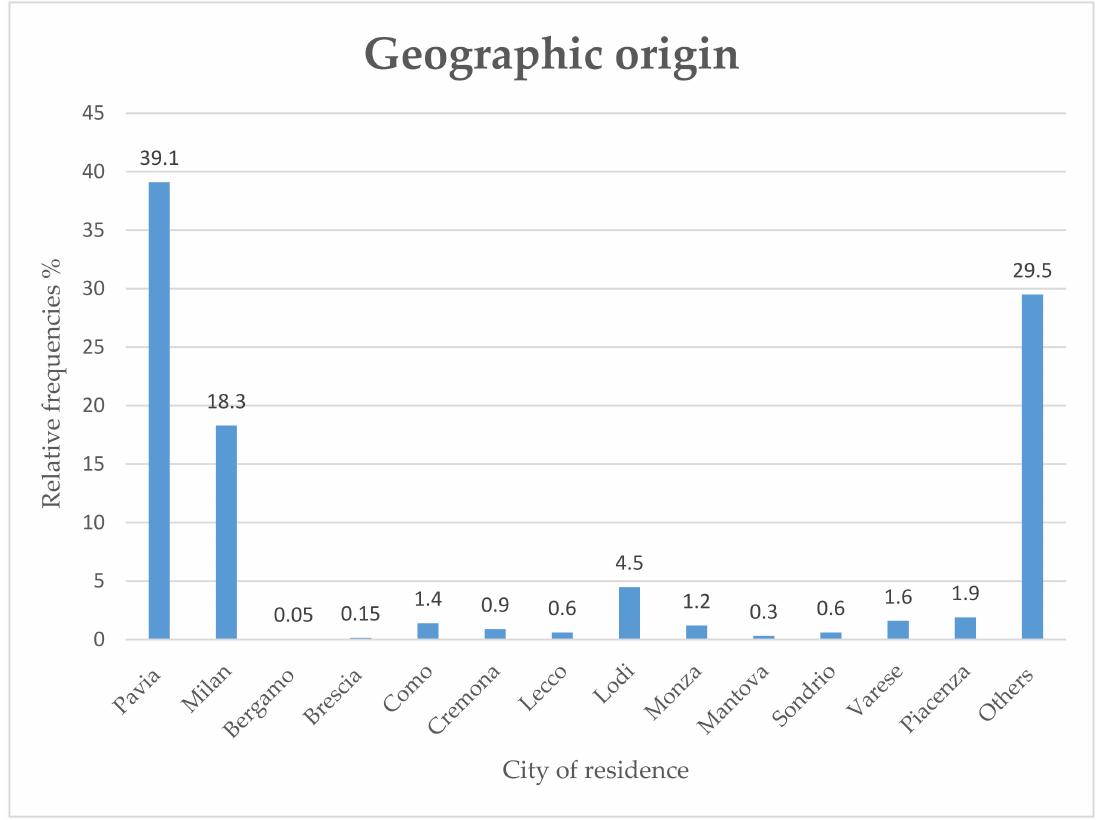
Figure 1. The image shows the distribution of the geographical area of the patients’ accessing to hospital in